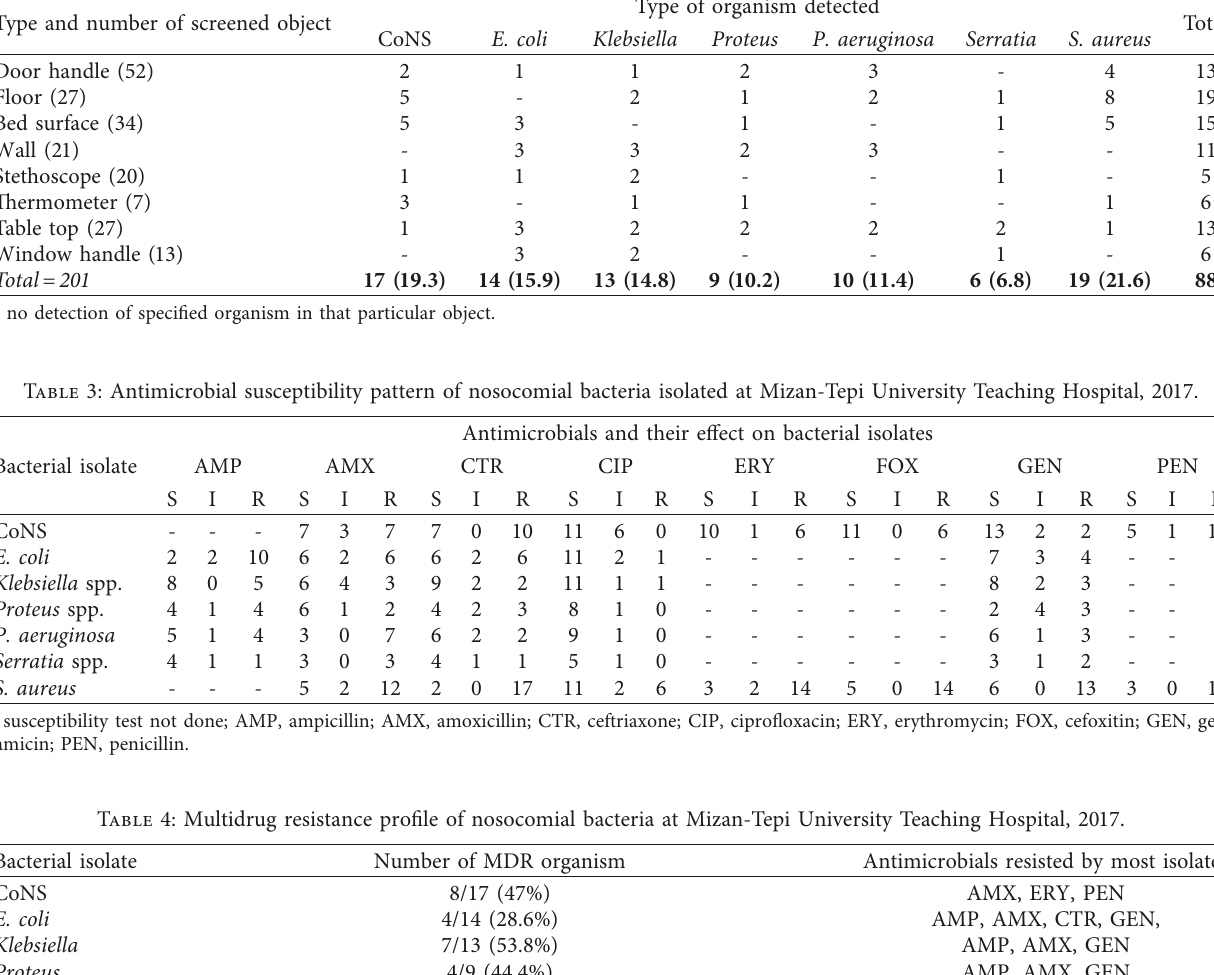
Table 2: Total number of screened equipment and surfaces and organisms detected at Mizan-Tepi University Teaching Hospital, 2017. Type and number of screened object